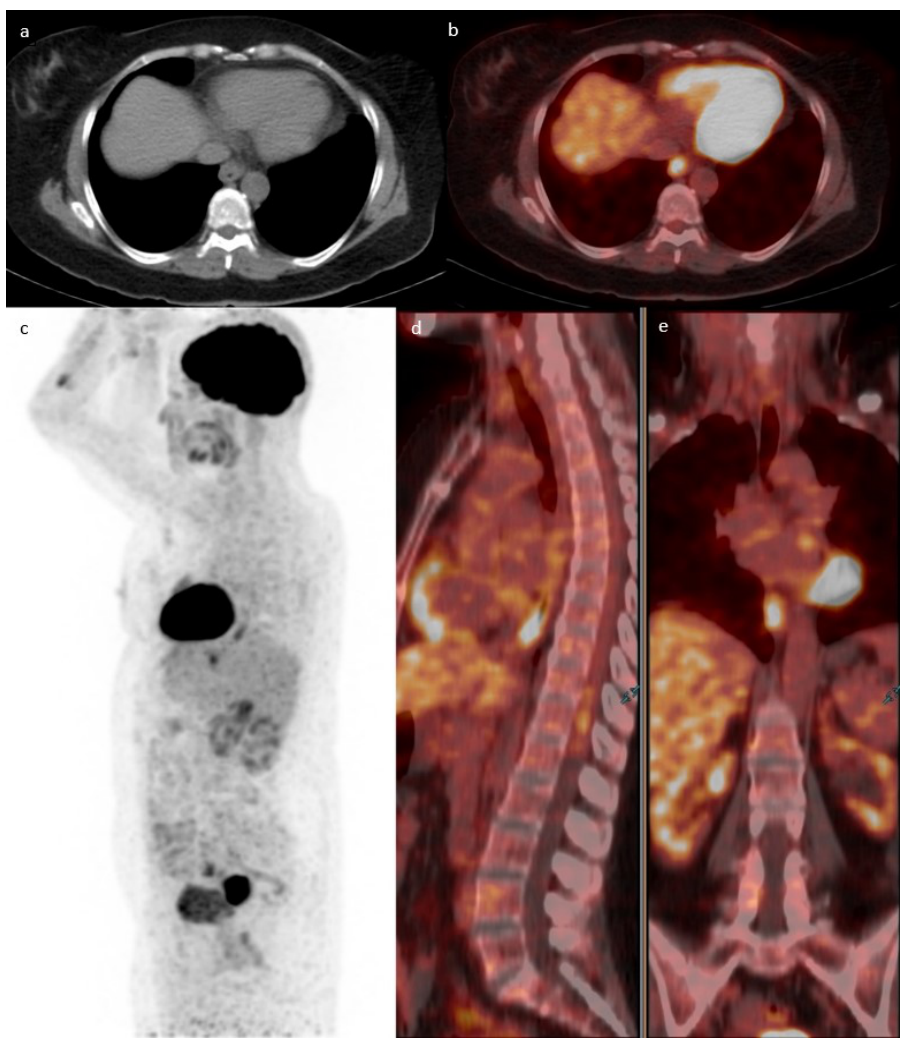
Figure 5. Case of a 70-year-old female known to have uterine cervical cancer. Axial CT ( a ) fused with PET ( b ) showing a focus of uptake in the distal esophagus with an SUVmax of 5.6. MIP ( c )-fused sagittal ( d ) and axial PET/CT ( e ) showing increased linear uptake within the distal aspect of the esophagus. The patient underwent gastroscopy, which revealed inflammatory processes in keeping with esophagitis and no evidence of malignancy.